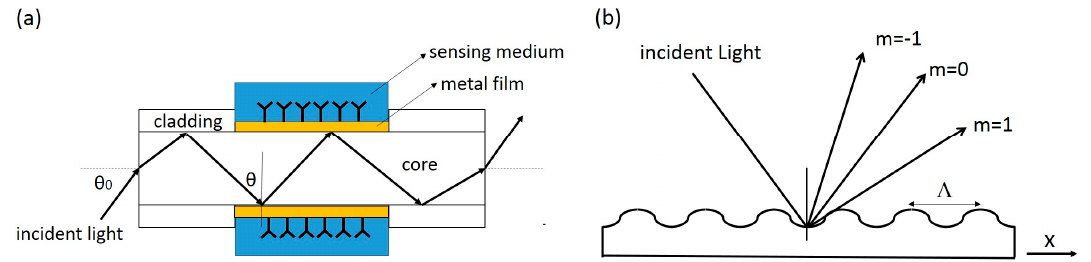
Figure 3. Schematic illustrations of ( a ) a fiber-optic SPR sensor and ( b ) light diffraction upon a periodic grating.